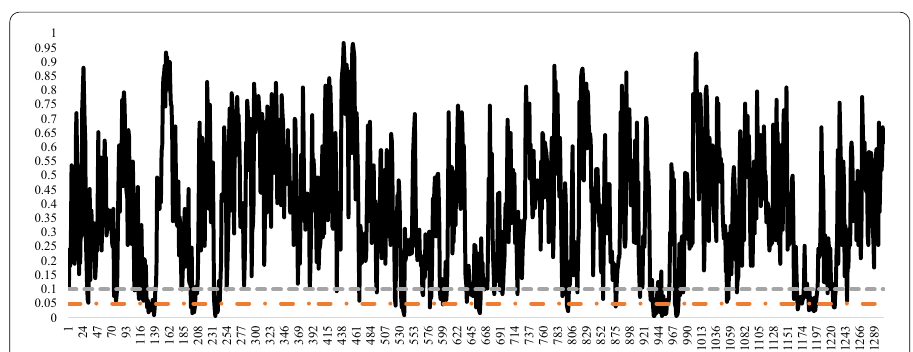
Fig. 23 The evolving p values of the GS test statistic checked for the Ethereum (ETH) in 50-day window length